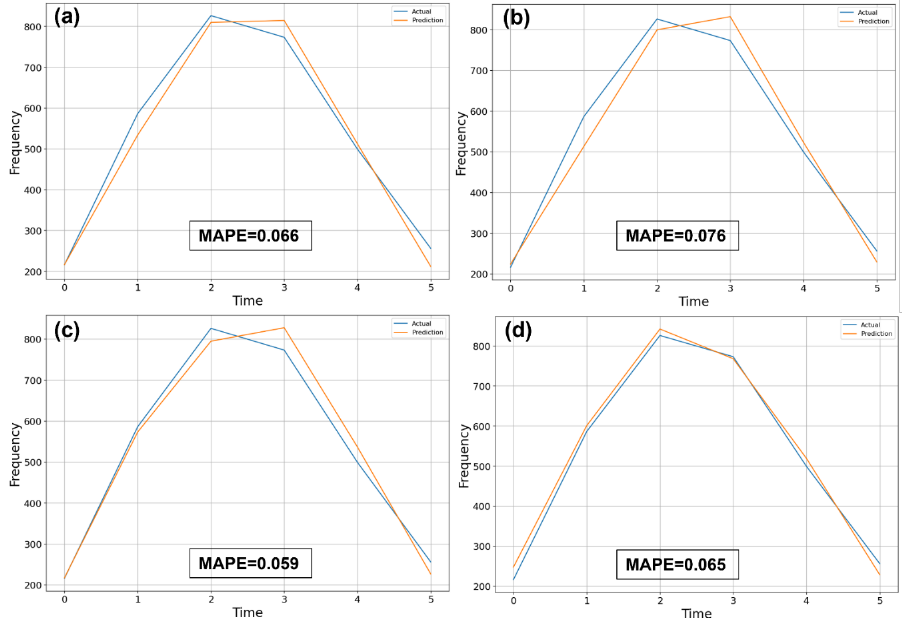
Figure 6. Prediction results with test data (marine accidents by watch duty time in 2020) for each LSTM: ( a ) LSTM1 (MAPE = 0.087), ( b ) LSTM2 (MAPE = 0.107), ( c ) LSTM3 (MAPE = 0.076), and ( d ) LSTM4 (MAPE = 0.133). The numbers 0 to 5 in the time axis represent the navigator’s watch duty time 00 – 04, 04 – 08, 08 – 12, 12 – 16, 16 – 20, and 20 – 24, respectively. Blue and orange lines represent actual and predicted values, respectively.